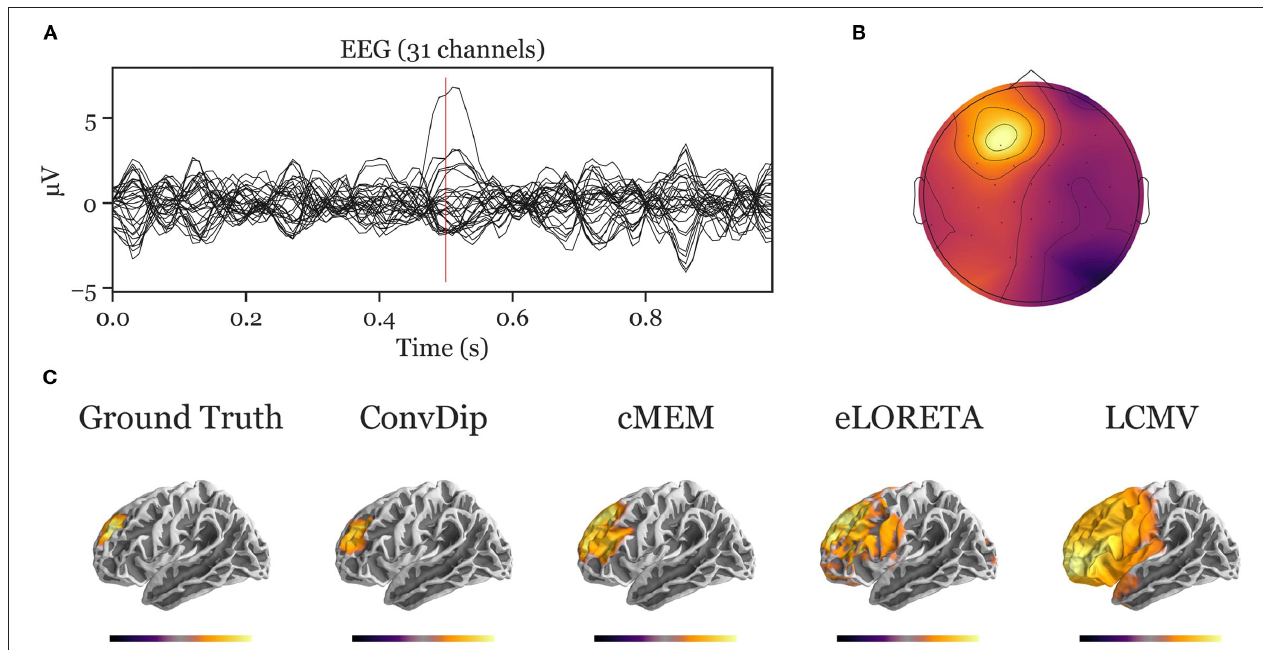
FIGURE A1 | Inverse solution of a simulation containing a single source cluster. An exemplary, representative sample of inverse solutions for a single source cluster. (A) The ERP at each of the 31 channels containing both signal (central peak) and realistic noise from real recordings. (B) The scalp map at the central ERP peak (as indicated by the vertical red line in A ). (C) The dipole moments plotted on the white matter surface of the template brain in lateral view of the left hemisphere. On the left , the ground truth source pattern is depicted with a source cluster in the frontal cortex of the left hemisphere. Various inverse solutions that aim to recover this pattern are depicted next to it. Voxels below 25% of the respective maximum are omitted for a clearer representation of the current